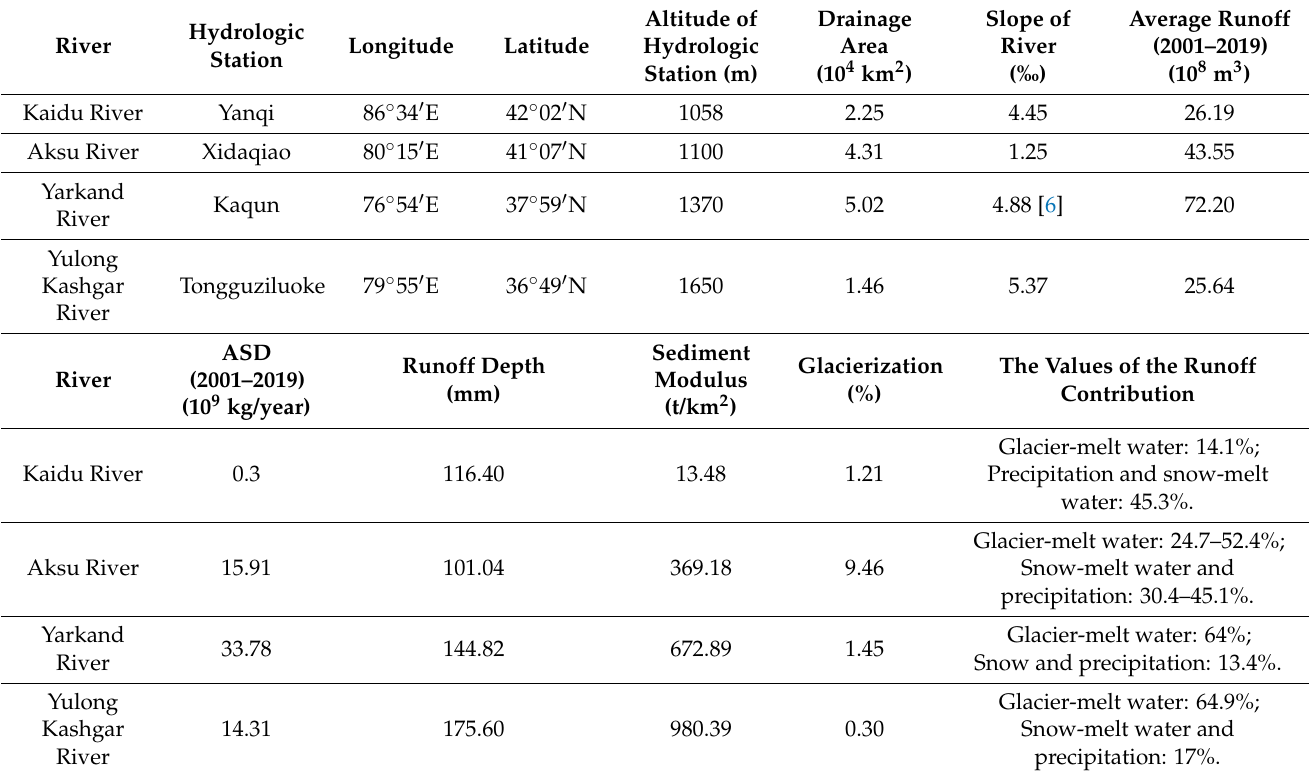
Table 1. Basic information of main rivers and hydrologic stations in the